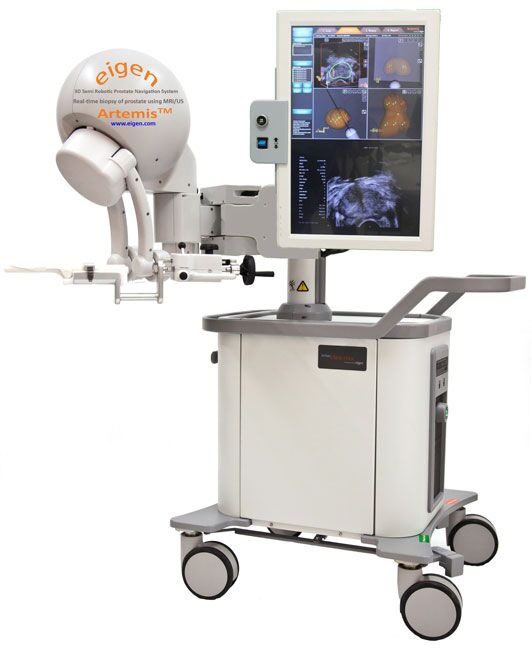
Artemis Eigen Fusion system [14].